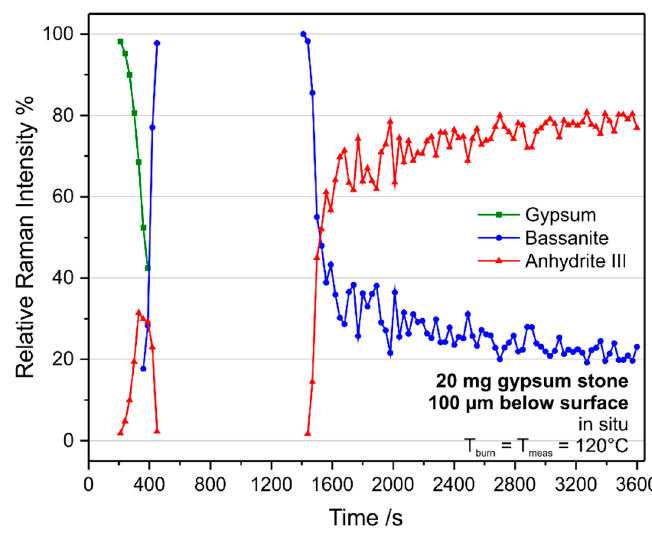
Figure 11. Change of relative intensities of the ν 1 bands of gypsum, bassanite, and anhydrite III during heating of a 20-mg gypsum stone to 120 °C. The measurements were carried out 100 µm below the surface.